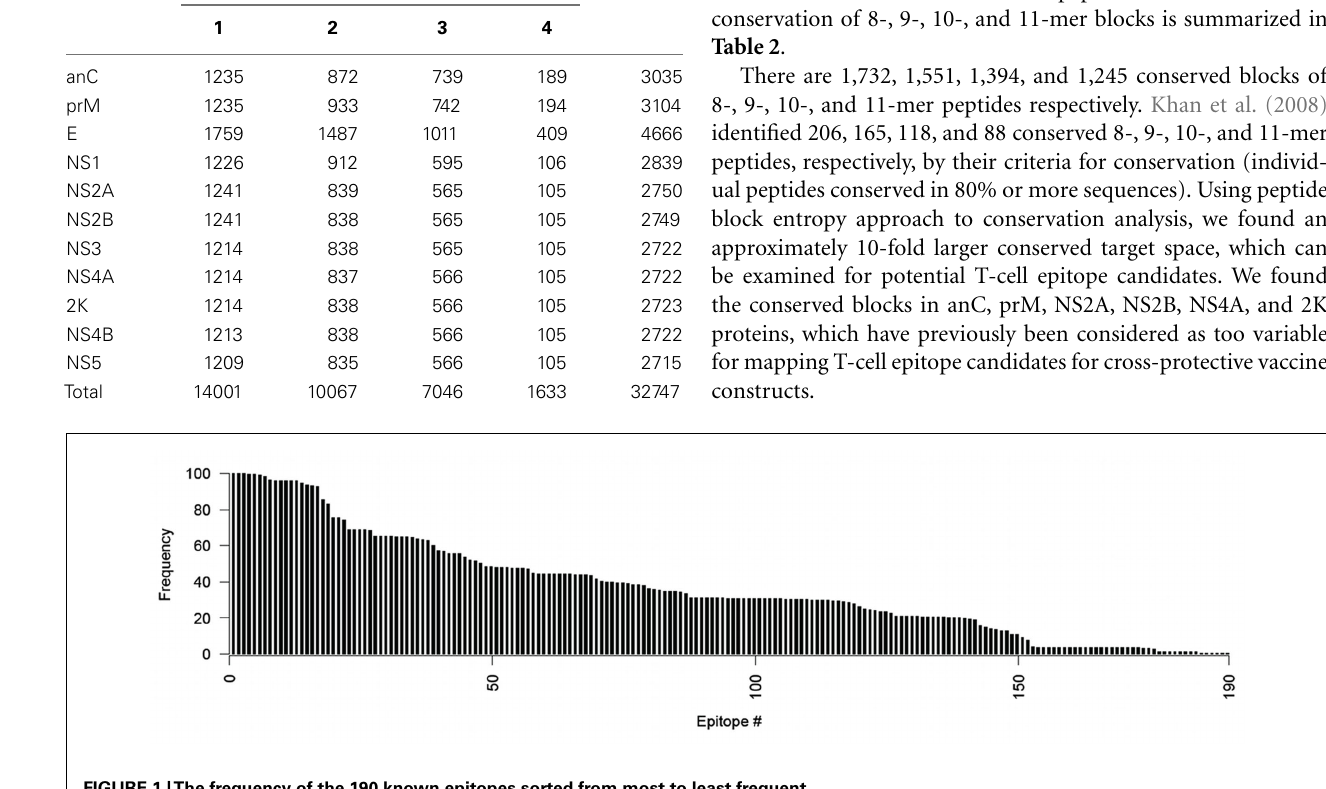
FIGURE 1 |The frequency of the 190 known epitopes sorted from most to least